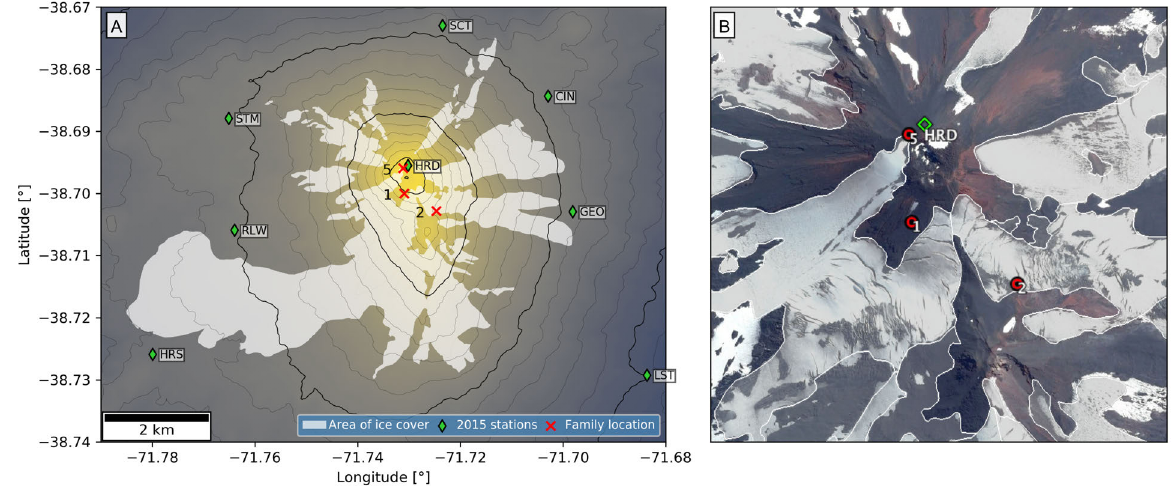
Figure 6: [A] Map of Llaima volcano summit area with the locations of the closest 2015 seismic stations used in this study marked with green diamonds. Also marked are the summit glacial areas (white area), as well as locations of three families (red crosses). Thick and thin contours mark 500 and 100 m altitude intervals, respectively. Colormap used is identical to that used in Figure 1. [B] Satellite image of the summit area of Llaima volcano, with station HRD marked (green diamond) and the locations of the largest three families (red circles). Also marked are the mapped glacial areas (white areas). Image source: Google-CNRS-Airbus-Digital Globe, captured on March 6 2016.